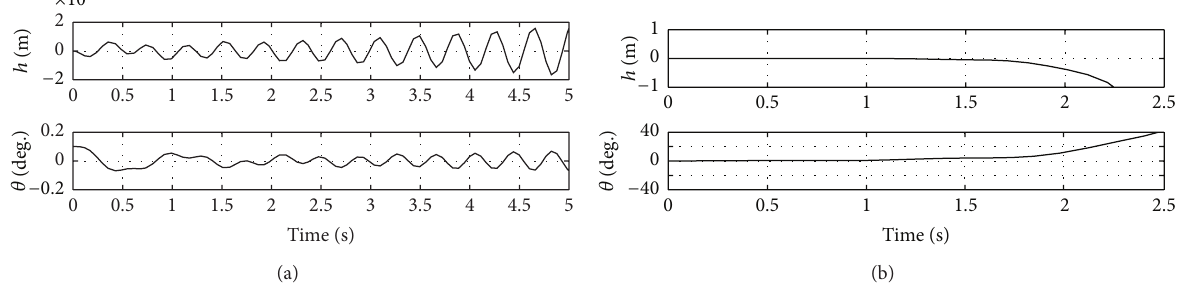
Figure 5: Responses of plunge displacement and torsional deflection without control for (a) flutter instability case or (b) divergence instability case.